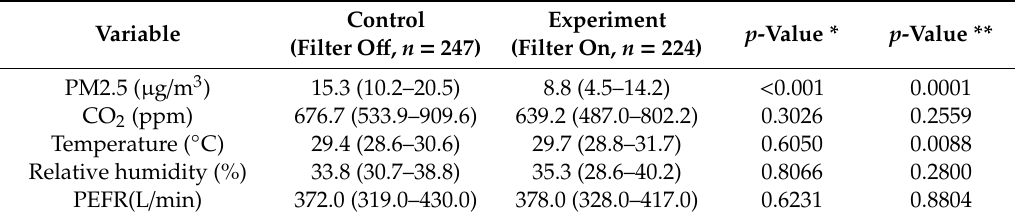
Table 3. Summary (median (IQR) of indoor air quality between control and experiment groups for phase 1 and 2.